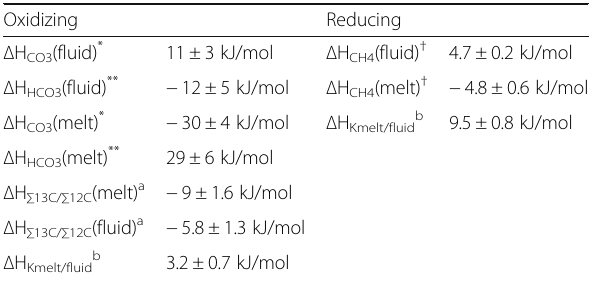
Table 2 Enthalpy of 13 C/ 12 C fractionation in coexisting fluid and melt in silicate-COH under oxidizing and reducing conditions (data from Mysen 2016, 2017) Oxidizing